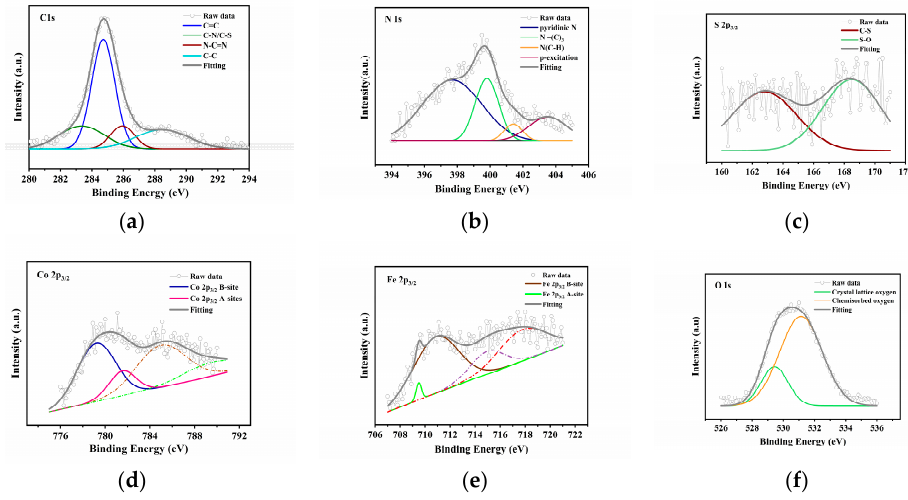
Figure 5. The XPS spectra of ( a ) C 1s; ( b ) N 1s; ( c ) S 2p; ( d ) Co 2p; ( e ) Fe 2p; ( f ) O 1s.